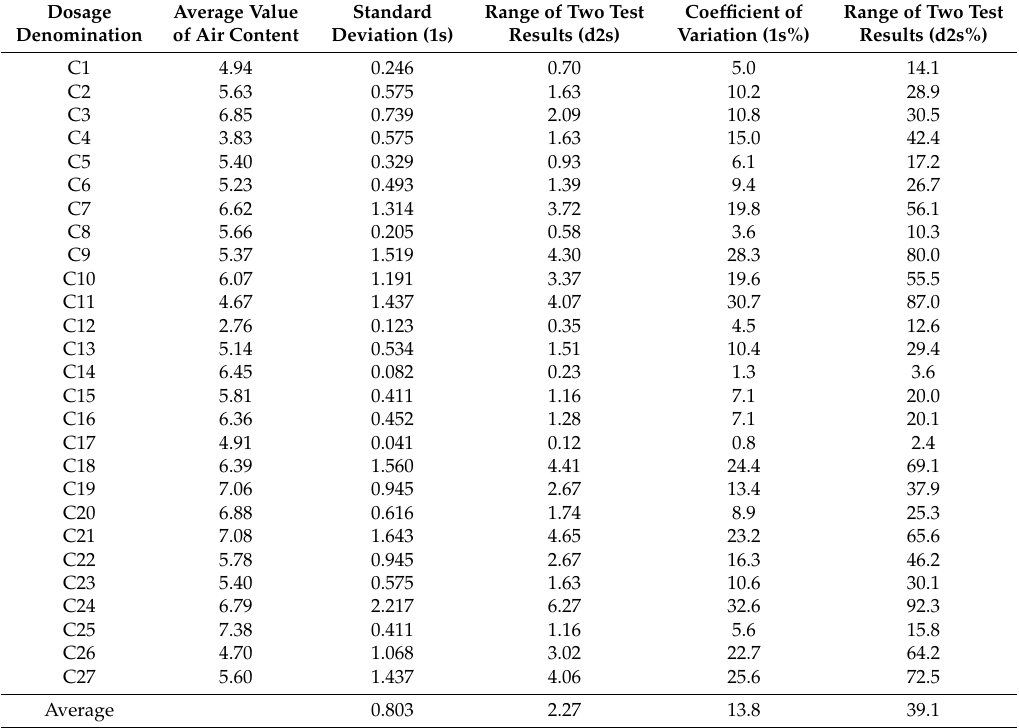
Table A3. Average value and dispersion data of the air content (%) of the 27 dosages (two slabs per